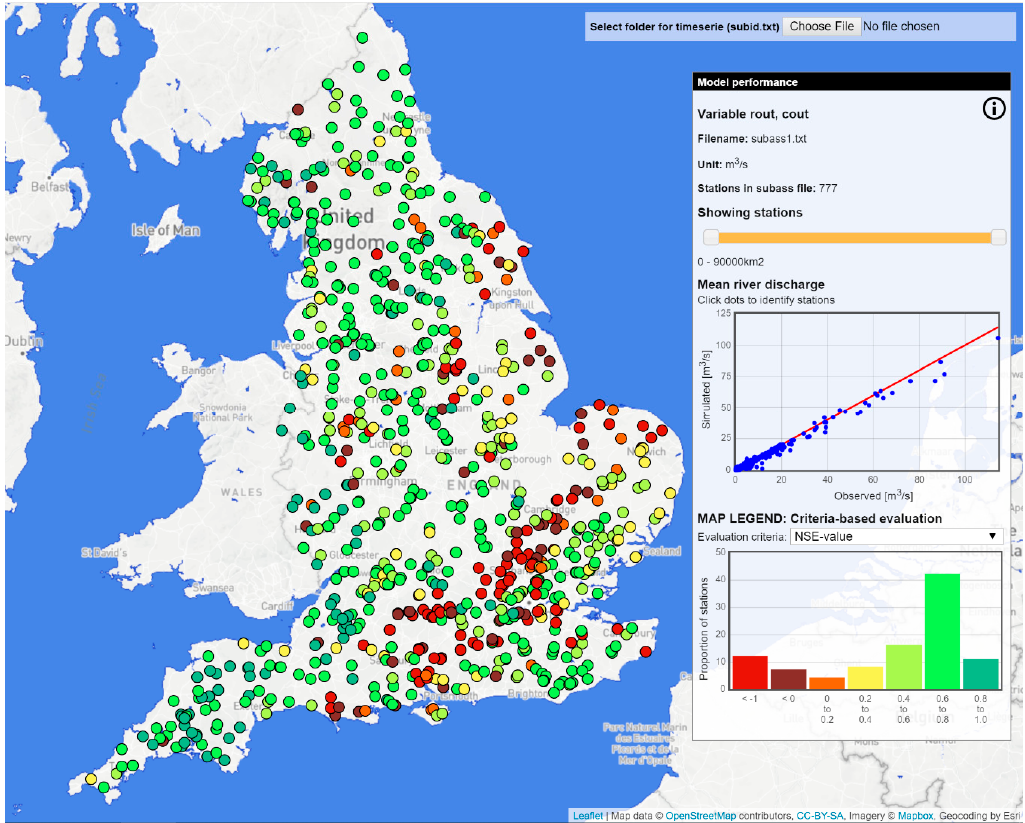
Figure 2. National performance map (based on relative error in the mean flow). The figure is a screenshot from the online calibration tool.